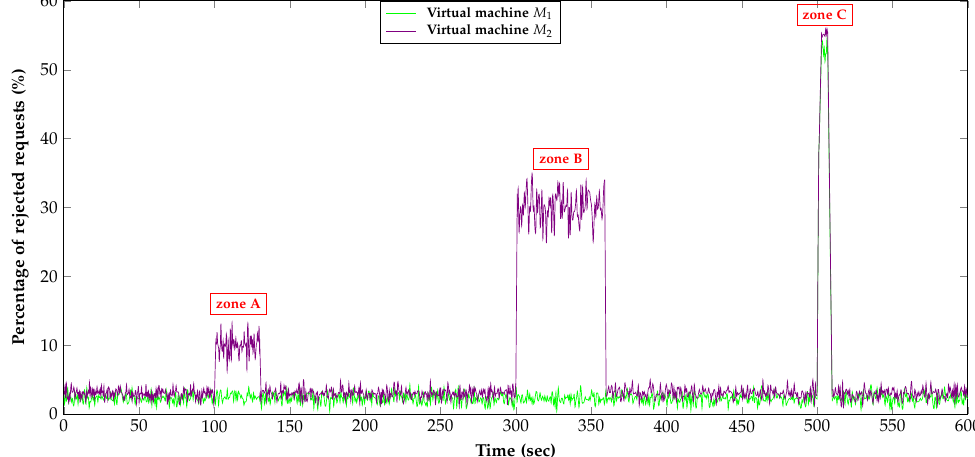
Figure 6. Comparison of request interception rates of the virtual machines M 1 and M 2